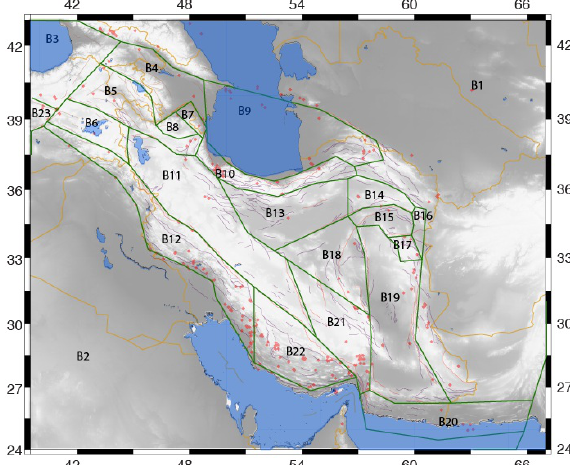
Figure 4. The initial pattern of the Iranian existing rigid blocks. For simplicity, The names of the initial blocks are arbitrary. We have chosen 23 blocks from the related documents and gathered them to make a unified initial pattern of the ex- isting blocks in the region of the study. B1 and B2 are the representatives for the main plates Eurasia and Arabia re-